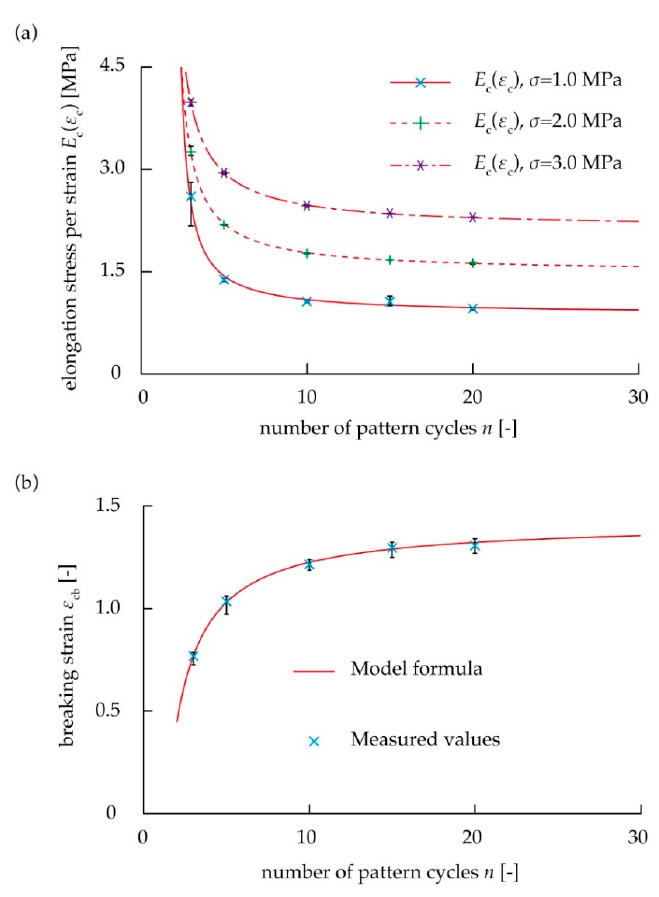
Figure 5. Comparison between fitting curve by theoretical and measured values: ( a ) Relation between n and elongation stress per strain, ( b ) Relationship between n and breaking strain.